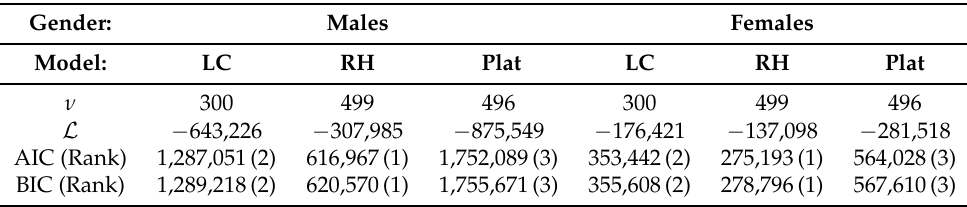
Table 1. Log-likelihood, AIC and BIC statistics for LC, RH and Plat model. Ages 0–100 and years 1915–2014, Italian population.